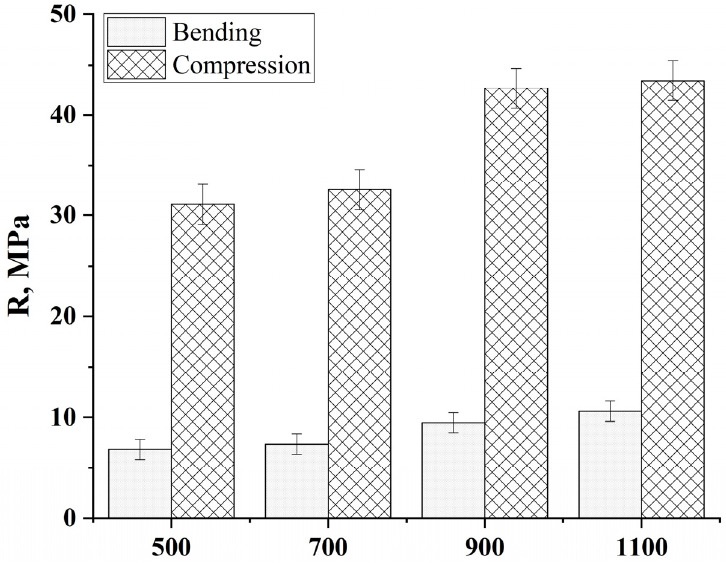
Figure 11. Bending and compressive strength of the ceramics after heat treatment at 500 °C, 700 °C, 900 °C and 1100 °C. 900 ◦ C and 1100 ◦